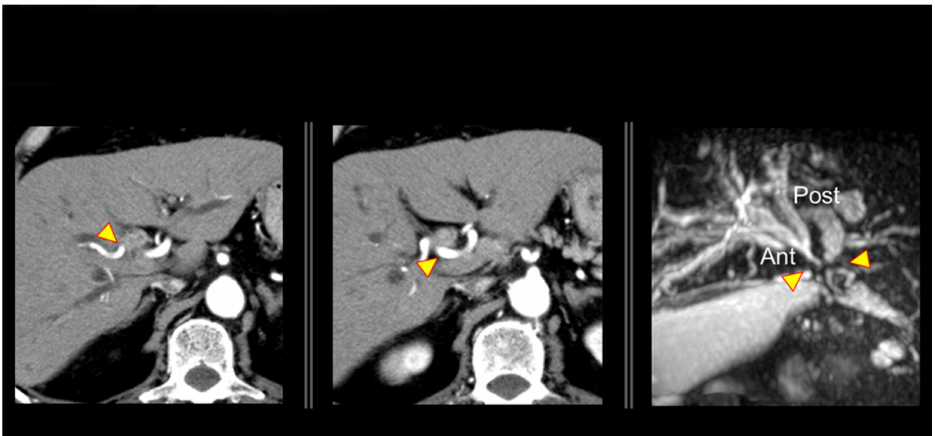
Figure 2. Advanced case of perihilar cholangiocarcinoma (T4N1M0 Stage IIIc) that required left hepatectomy with concomitant hepatic artery and portal vein